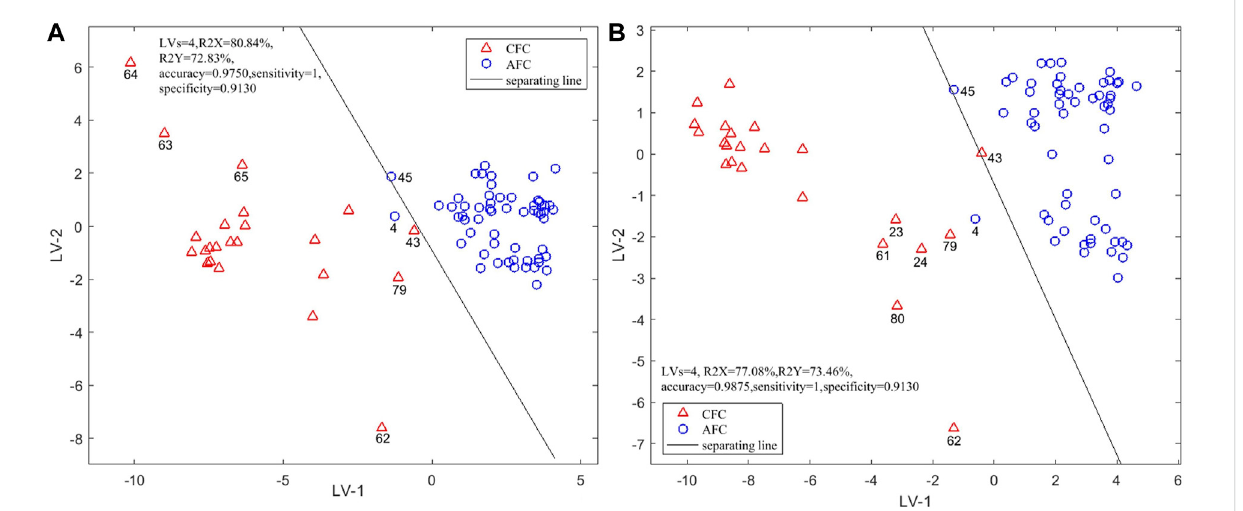
FIGURE 6 ROC curves of single-source PLS-DA authenticity and counterfeit identi fi cation model based on electronic nose (A) , electronic tongue (B) , electronic eye (C) and NIR spectra (D) and three-source fusion (E) (EN + ET + EE) and four-source fusion (F) (EN + ET + EE + NIR).